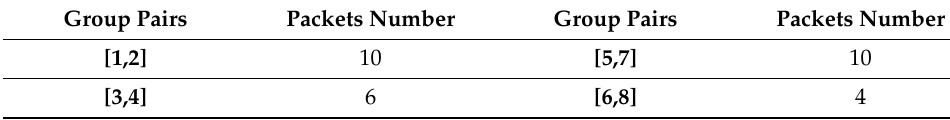
Table 4. The processes pairs with maximum communication packets. Group Pairs